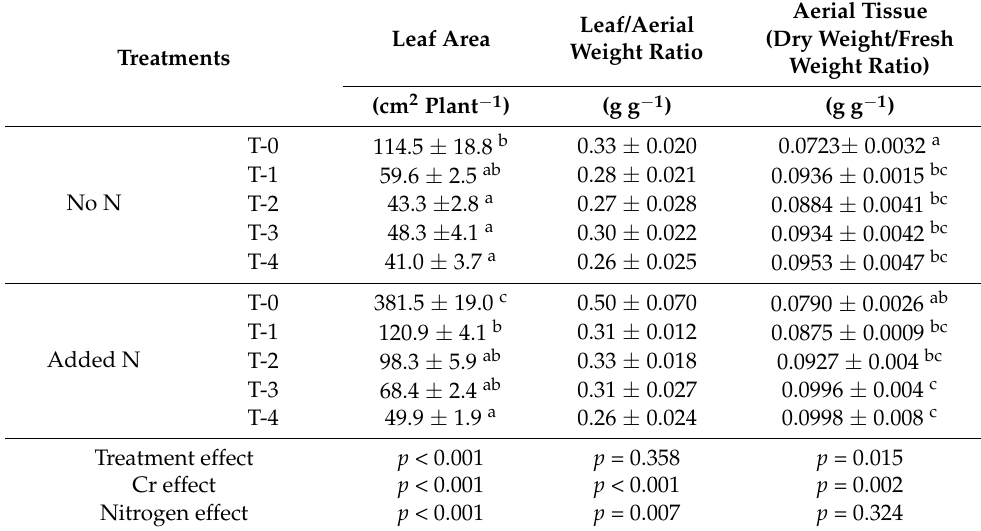
Table 3. Leaf area, leaf/total aerial weight ratio and fresh weight to dry weight ratio of aerial tissues.